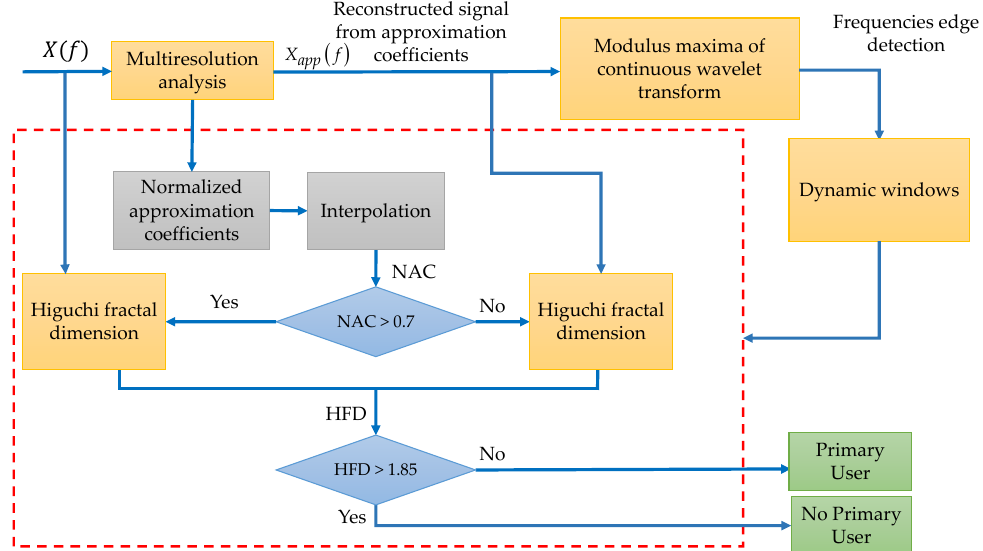
Figure 3. Complete scheme of the proposed first methodology. NAC: normalized approximation coefficients; HFD: Higuchi fractal dimension.